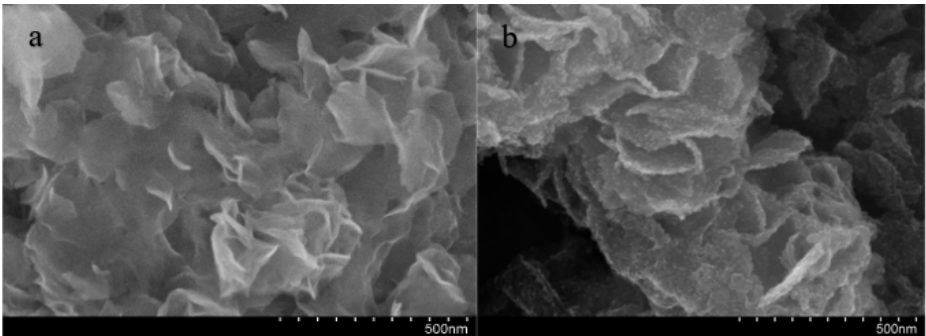
Figure 6. SEM images of ( a ) MoS 2 nanosheets and ( b ) MoS 2 /ZnO nanomaterials.